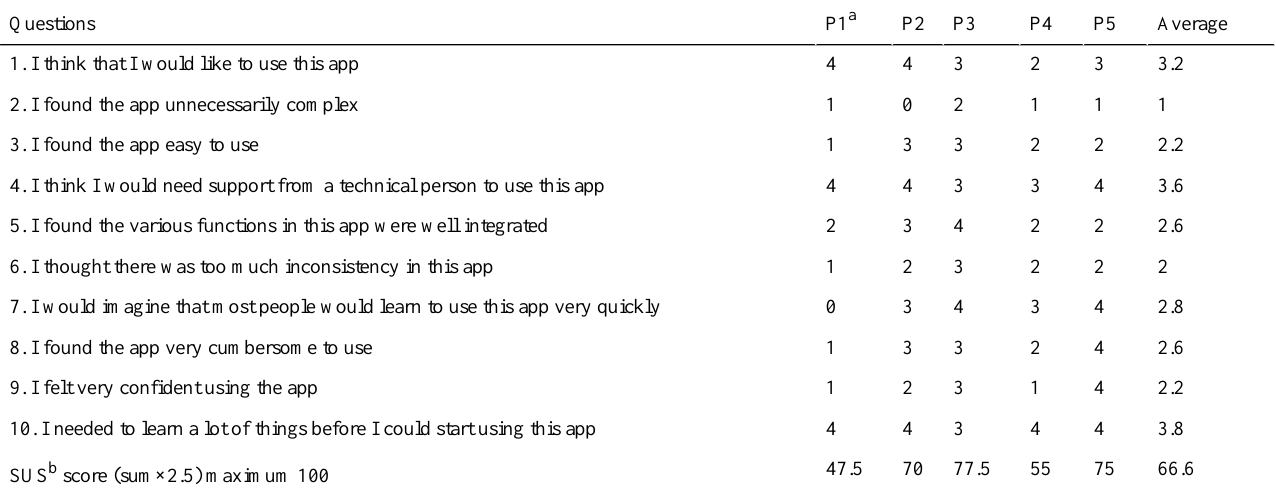
Table 2. Result of the System Usability